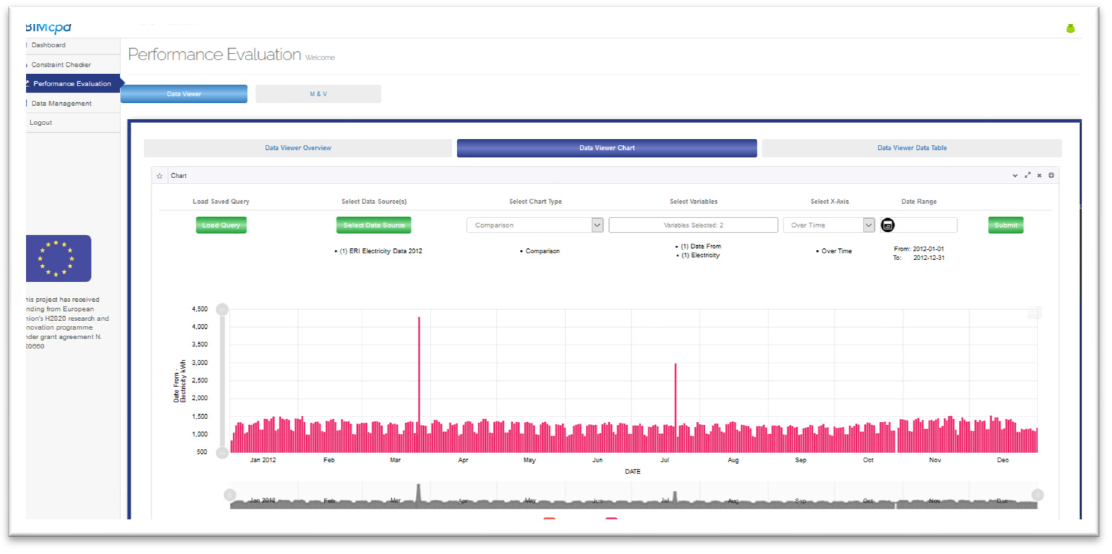
Figure 4. Data Viewer